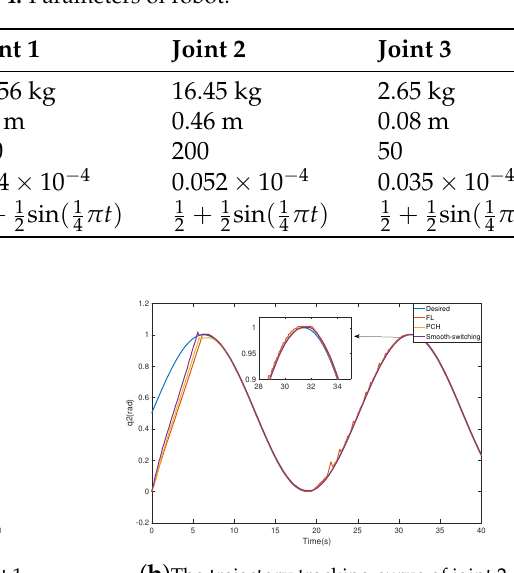
Table 4. Parameters of robot.